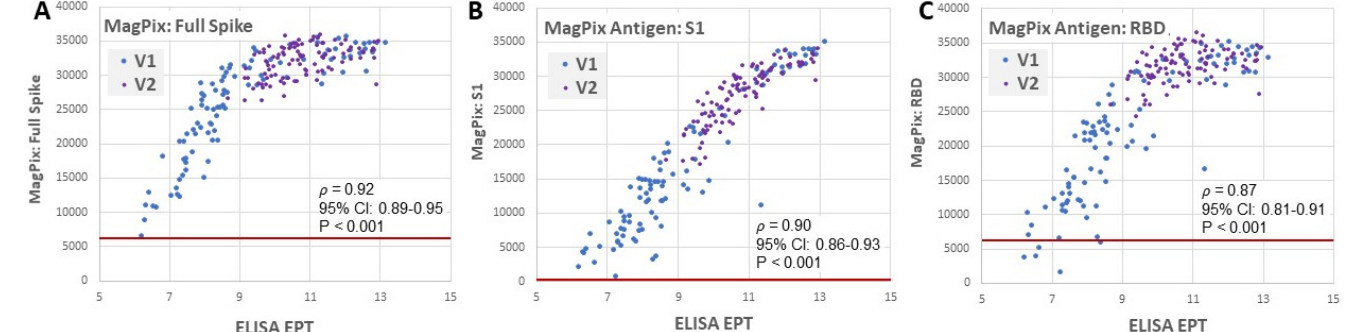
Figure 2. Correlation of anti-spike ELISA with MagPix immunoassays to different spike regions. Multiplex immunoassays were performed using recombinant antigens containing different regions of the viral spike proteins: ( A ) SARS-CoV-2 full trimeric spike, ( B ) the spike S1 domain, and ( C ) the spike RBD. Graphed is the Magpix median fluorescence intensity for each bead set (y-axis) and corresponding ELISA endpoint titer (x-axis). The red line represents the MagPix 98% cutoff values for each antigen: full spike = 6364, S1 = 337, RBD = 6360. Spearman’s rank correlation coefficient with 95% confidence intervals and p -value are shown.